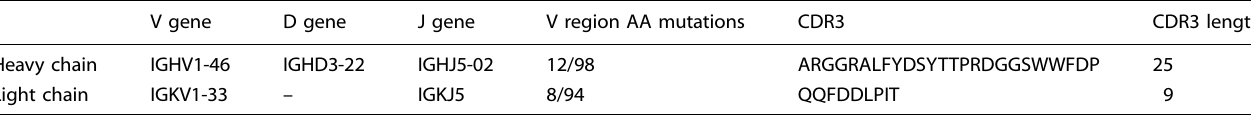
Table 1. Variable region analysis of antibody